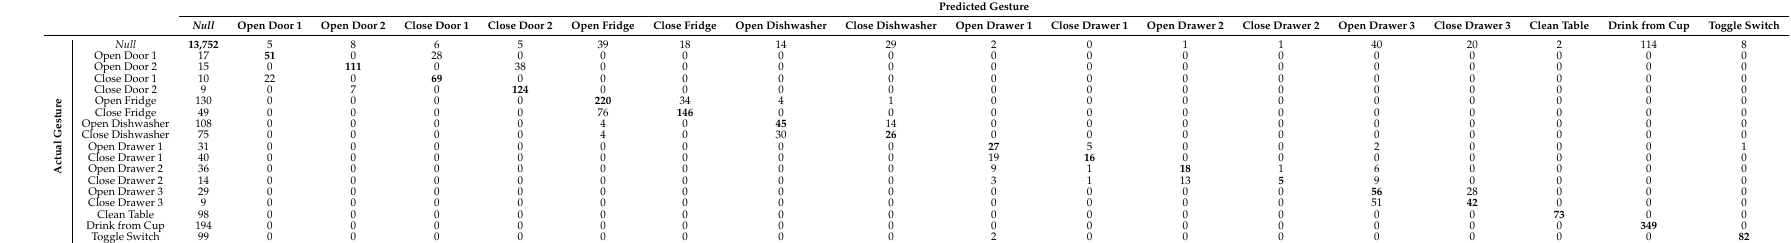
Table 6. Confusion matrix for OPPORTUNITY dataset using the baseline